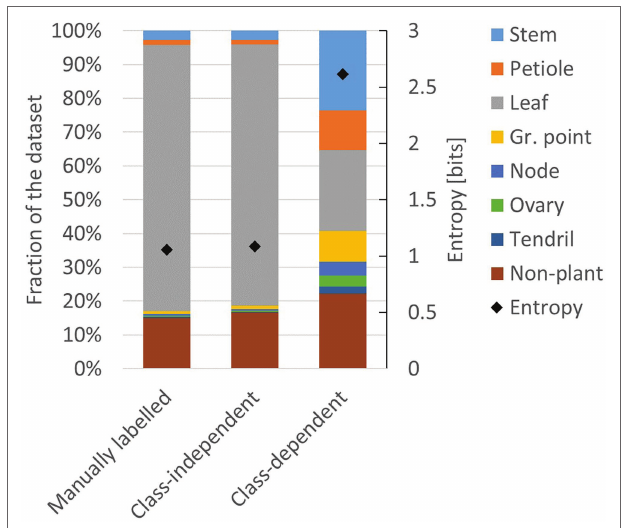
FIGURE 4 | Composition of the manually labelled dataset, the class- independent training set and the class-dependent training set. The black diamonds show the level of entropy (secondary axis) according to Eq.